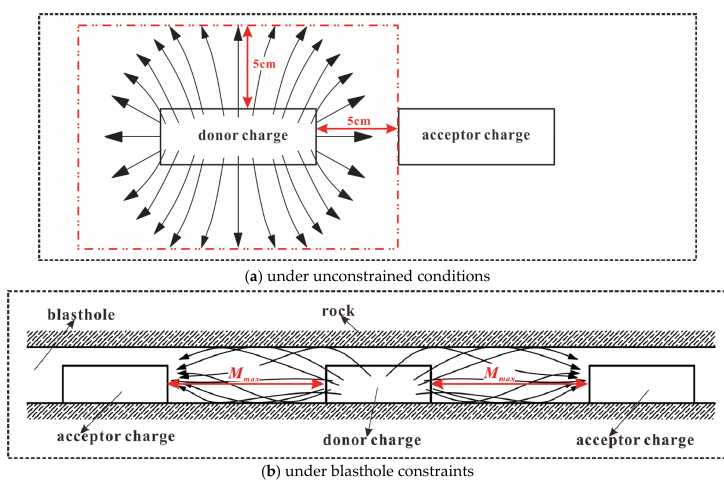
Figure 5. Propagation of detonation waves and products under various constraints. ( a ) under unconstrained conditions, ( b ) under blasthole constraints.